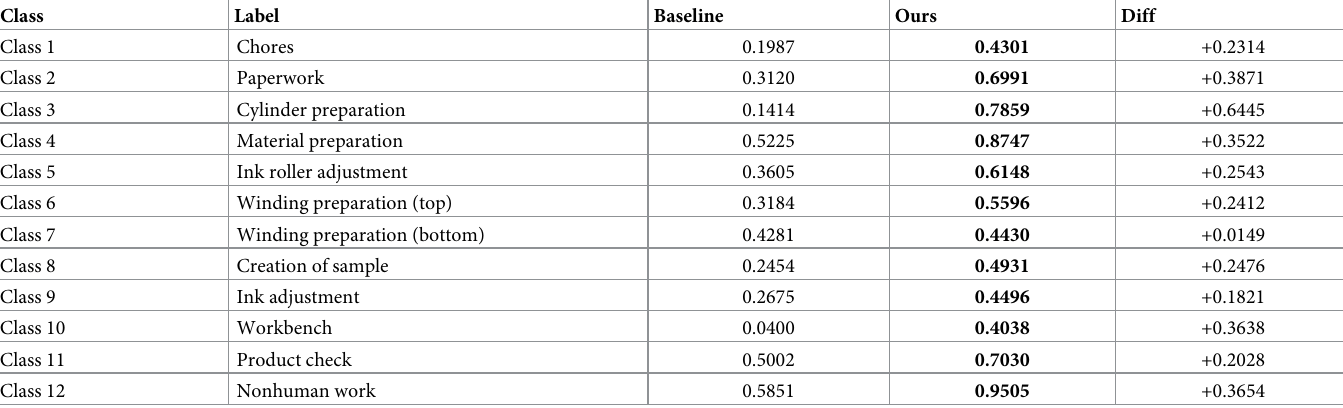
Table 9. Comparison of label-by-label F1 score between the two LSTM-CNN models (test set). The highest scores are expressed in a bold